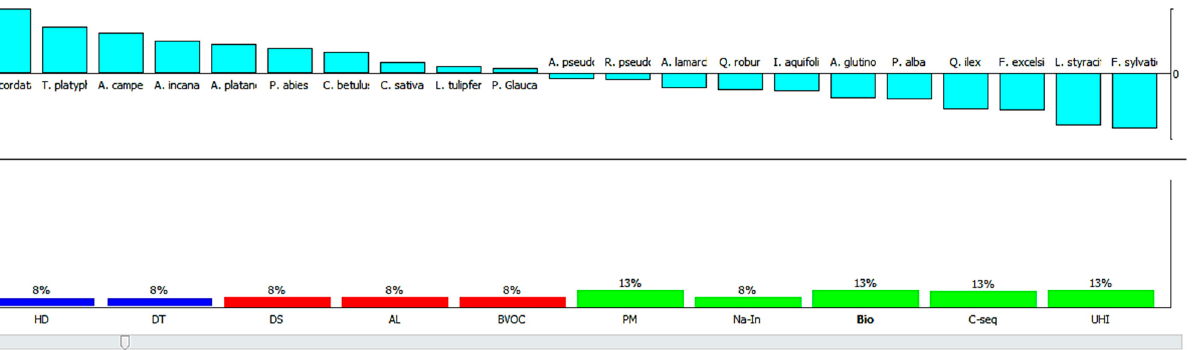
Figure 4. Ranking of plant species shown in the upper part of the bar chart according to scenario (S3) for PM mitigation, ability to support biodiversity, net carbon sequestration, and reducing urban heat island effect. The lower part of the bar chart shows an equally high importance for PM mitigation, ability to support biodiversity, net carbon sequestration, and reducing the urban heat island effect (green bars). The criteria including hardiness, drought tolerance (dark blue bars), disease susceptibility, allergenicity, BVOC emissions (red bars), native-invasive (green bar) are adjusted as having low importance. Plant species are ordered from best to worst. (For an interpretation of the references to color in this figure legend, the reader is referred to the web version of this